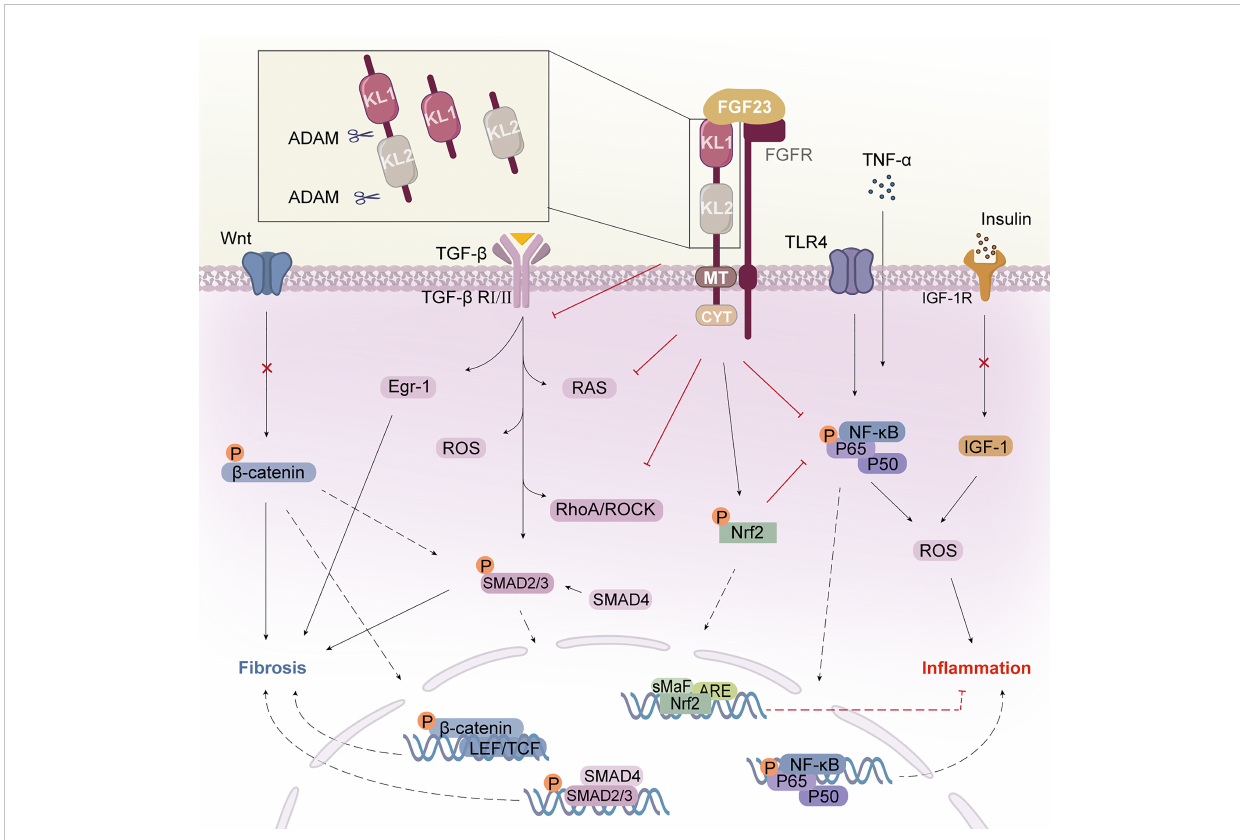
FIGURE 1 Klotho structure and its mechanism of action. Klotho consists of two extracellular structural domains (KL1 and KL2), a transmembrane segment (TM), and a short non-signaling cytoplasmic tail (CYT). Enzymes such as ADAM10 or ADAM17 can cleave Klotho to produce a soluble form called s-Klotho. FGF23 binds to the Klotho/FGFR1c receptor in the renal tubule to form the Klotho/FGFR/FGF23 signaling complex, which exerts multiple actions. Klotho binds to the TGF- b receptor, speci fi cally the T b RII component, and inhibits TGF- b and its downstream pathways and molecular activation. Klotho inhibits the activation of the in fl ammatory NF- k B pathway and increases signaling in the Nrf2 pathway. Klotho block IGF-1 receptor signaling as well as the expression of target genes downstream of Wnt/ b -catenin. Klotho inhibits in fl ammation and fi brosis in diabetic nephropathy through multiple pathways. KL, Klotho; FGF23, fi broblast growth factor 23; FGFR, FGF receptor; AMAD, a disintegrin and metalloproteases; TGF- b , transforming growth factor b ; T b RII, TGF- b receptor type II; Egr-1, early growth response factor 1; RAS, agents renin-angiotensin system; ROS, reactive oxygen species; TLR4, toll-like receptor 4; Nrf2, nuclear factor-erythroid 2-related factor 2; NF- k B, nuclear factor k B; IGF-1, insulin-like growth factor 1; IGF-1R, IGF-1